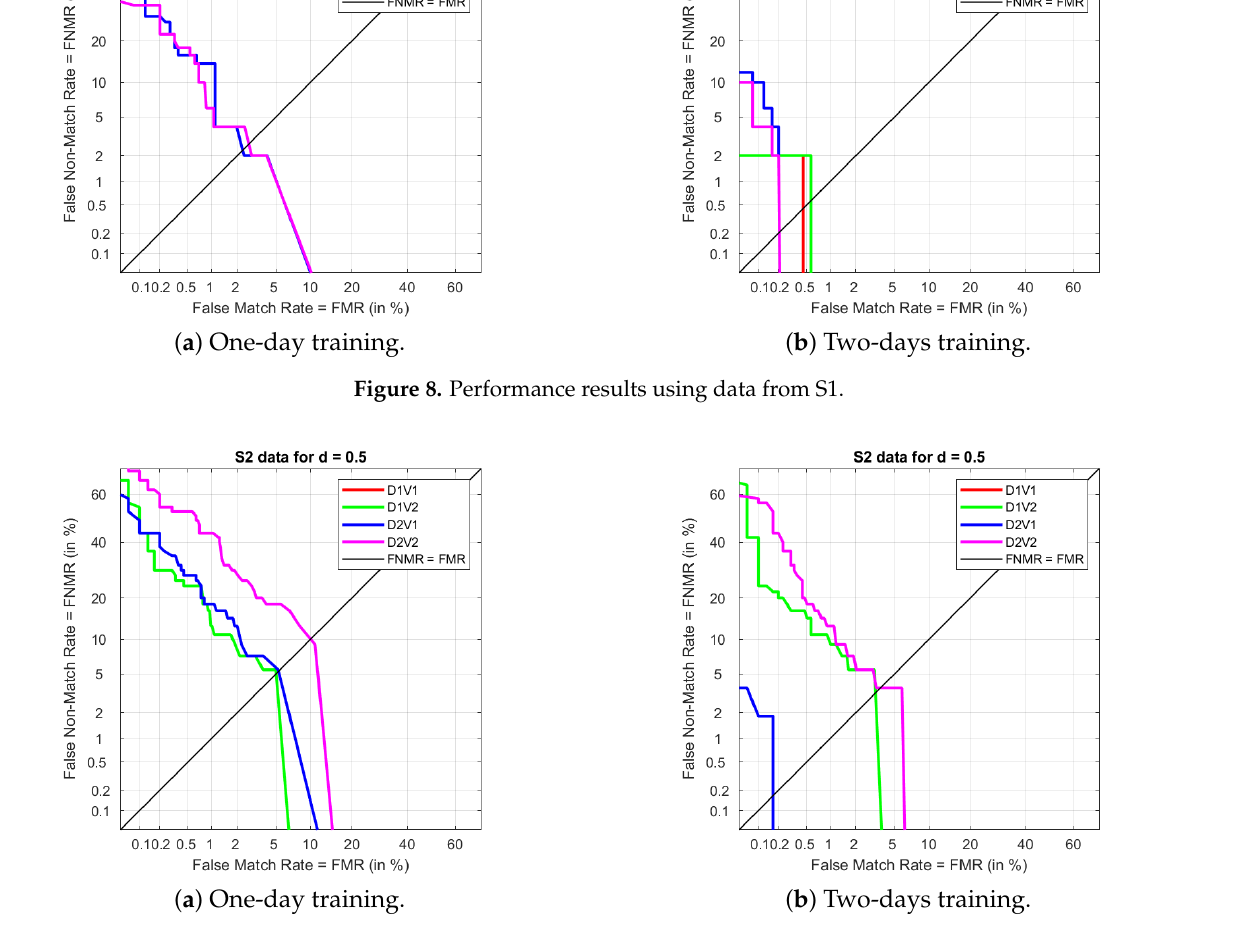
Figure 9. Performance results using data from